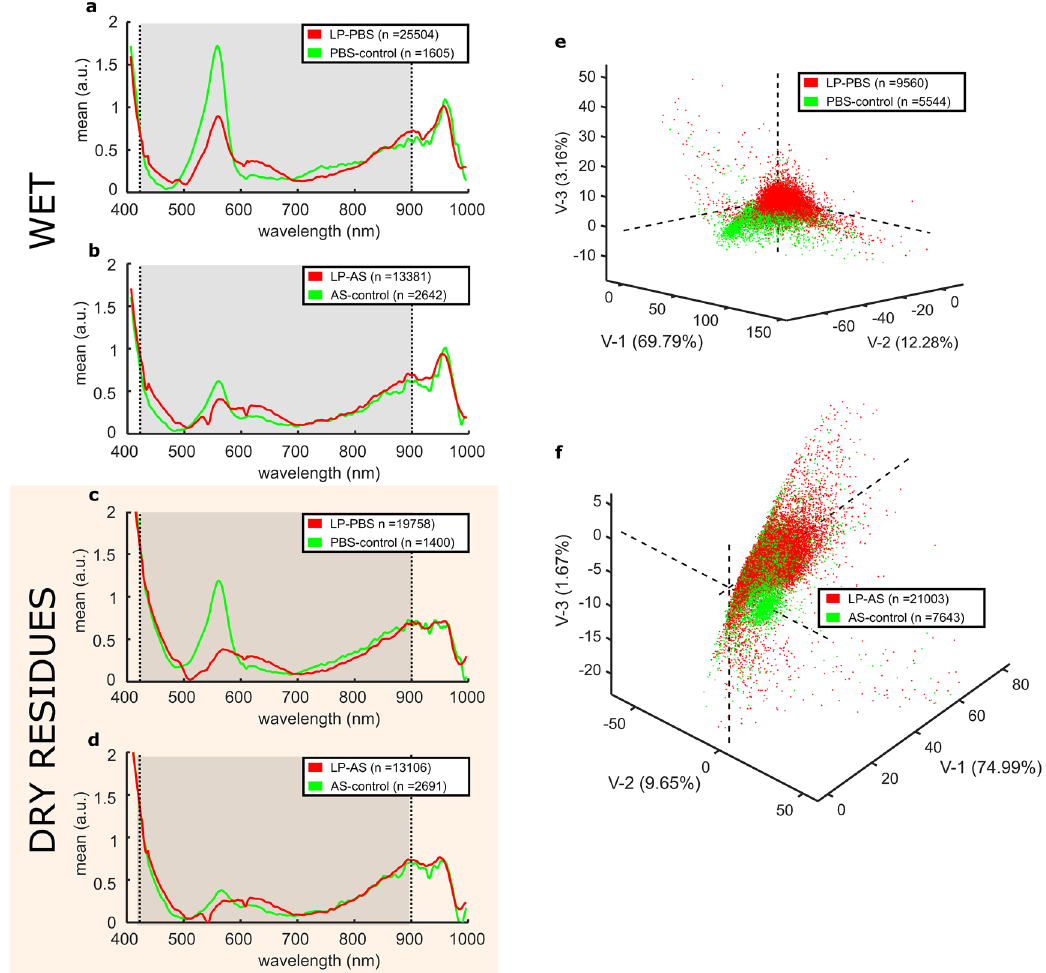
Figure 2. Pseudo-absorbance spectra. ( a,b ) mean pseudo-absorbance spectra obtained from lentiviral particles resuspended in PBS (LP-PBS) or artificial saliva (LP-AS), and their respective negative controls (PBS-control and AS-control). ( c,d) overall pseudo-absorbance spectra upon complete evaporation of the aqueous content. The concentration in ( a–d) was 4000 TU∙µL −1 . The shadowed area highlights the wavelength range in which shape features were more informative for the FFNN analysis. ( e) PLS-DA three-dimensional score plot of LP-PBS vs . PBS-control (three latent variables and captured variances: V1 = 0.70, V2 = 0.12, V3 = 0.03). ( f ) PLS-DA three-dimensional score plot of AS-PBS vs. AS-control (three latent variables and captured variances: V1 = 0.75, V2 = 0.10, V3 =